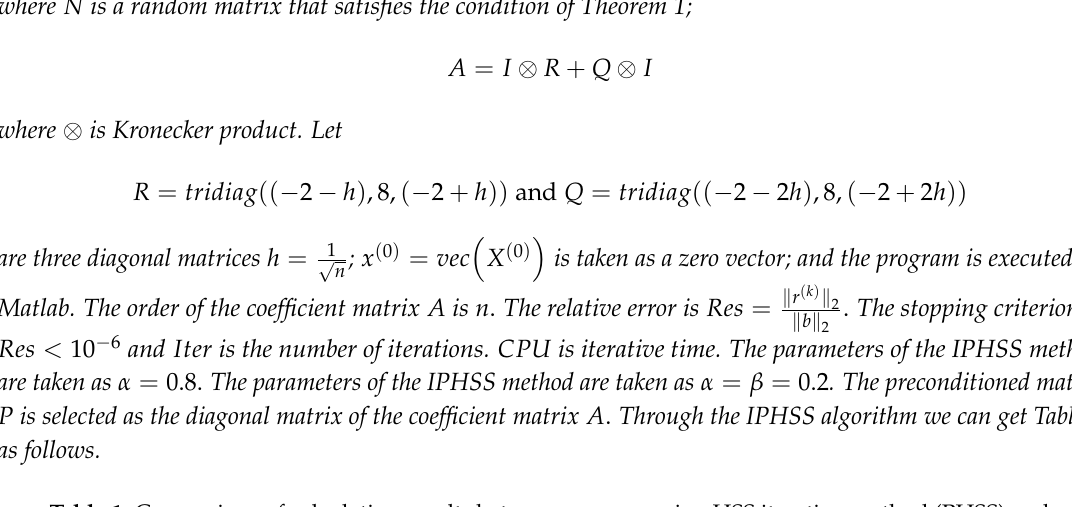
Table 1. Comparison of calculation results between preprocessing HSS iteration method (PHSS) and inexact PHSS algorithm (IPHSS)